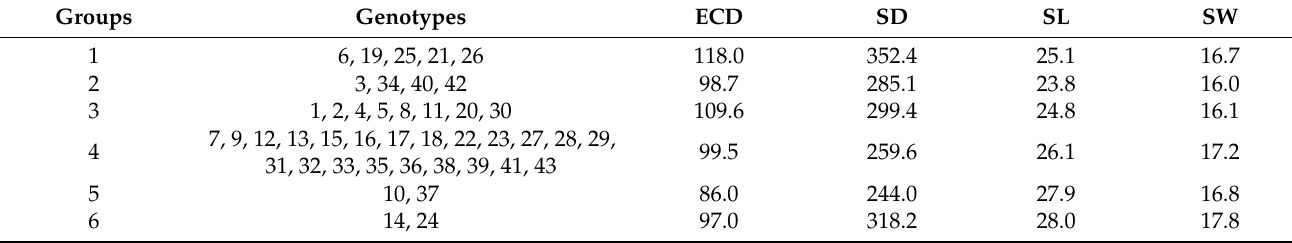
Table 4. Means of the leaf morpho-anatomical traits of Coffea canephora per UPGMA cluster considering ECD (epidermal cell density; cells mm − 2 ), SD (stomata density; unit mm − 2 ), SL (stomatal length; at major axis in µ m), and SW (stomatal width; at minor axis in µ